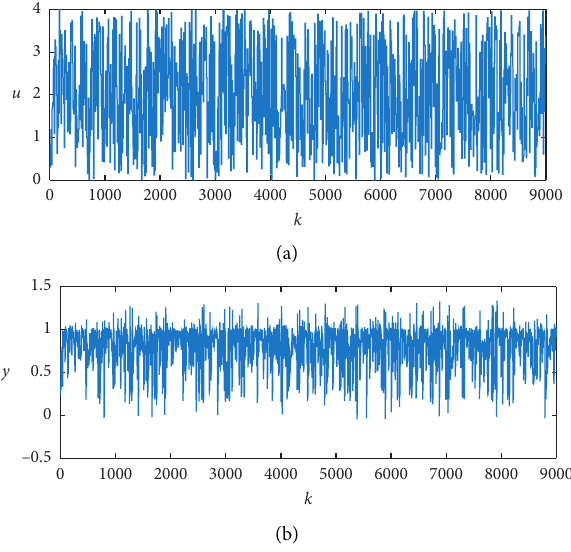
Figure 3: The system’s input and output versus k